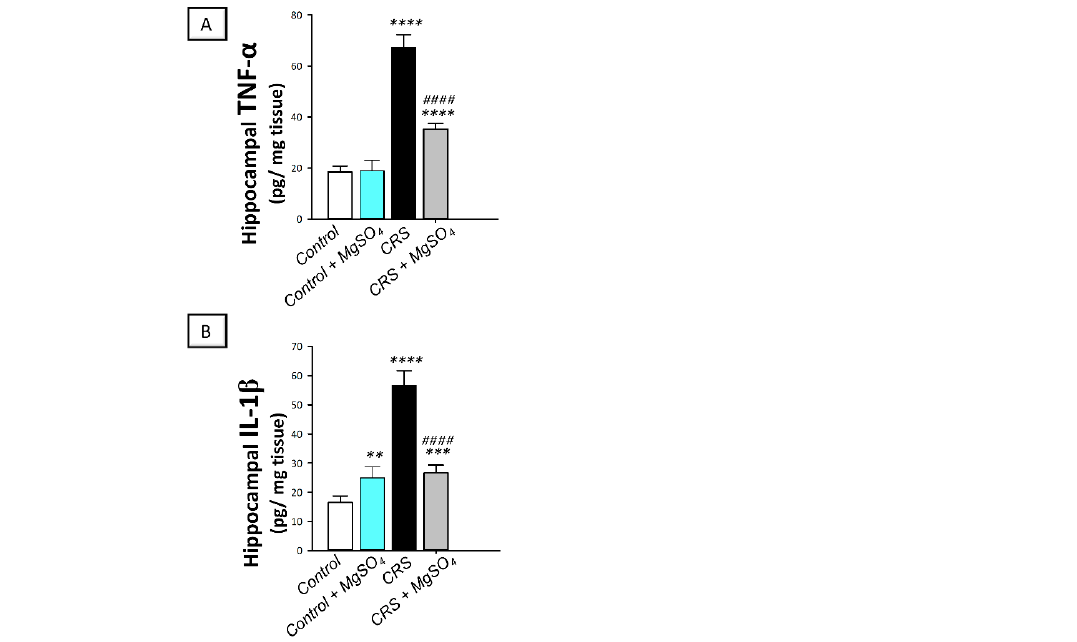
Figure 6. Effect of magnesium sulfate on the pro-inflammatory cytokine levels in the hippocampi of rats exposed to chronic restraint stress (CRS). Administration of magnesium sulfate suppressed the increased levels of tumor necrosis factor-alpha (TNF- α ; ( A )) [F (3, 20) = 244.6, p < 0.0001] and interleukin 1 beta (IL-1 β ; ( B )) [F (3, 20) = 159.2, p < 0.0001] in the hippocampi of rats exposed to CRS. Values are expressed as the mean of 6 rats ± standard deviation (S.D.). Statistical analysis was applied using one-way ANOVA followed by Tukey’s post-hoc test. Significant differences versus control animals are denoted by ** p < 0.01, *** p < 0.001, or **** p < 0.001. Significant differences versus CRS group are denoted by # ### p < 0.001. CRS, chronic restraint stress; MgSO 4 , magnesium sulfate.